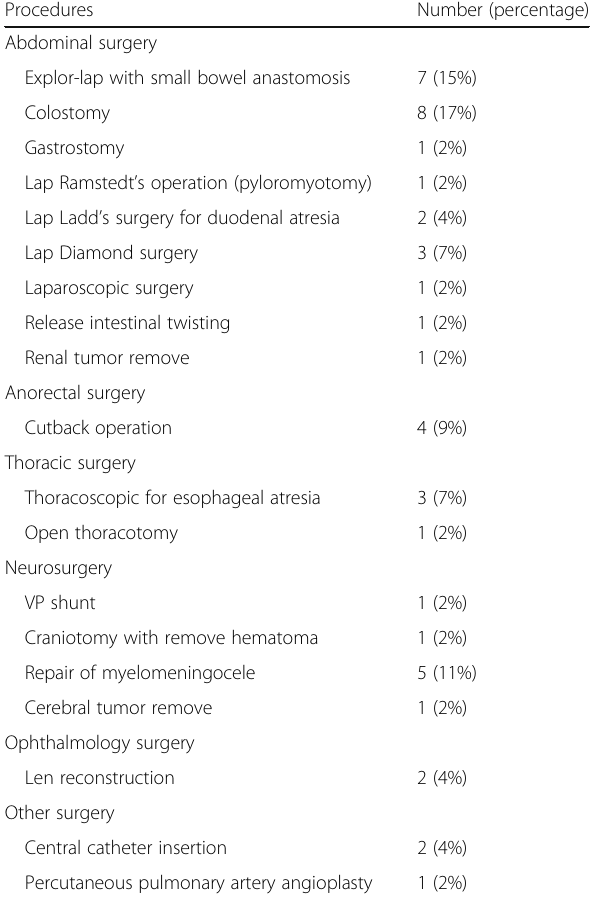
Table 1 Surgical